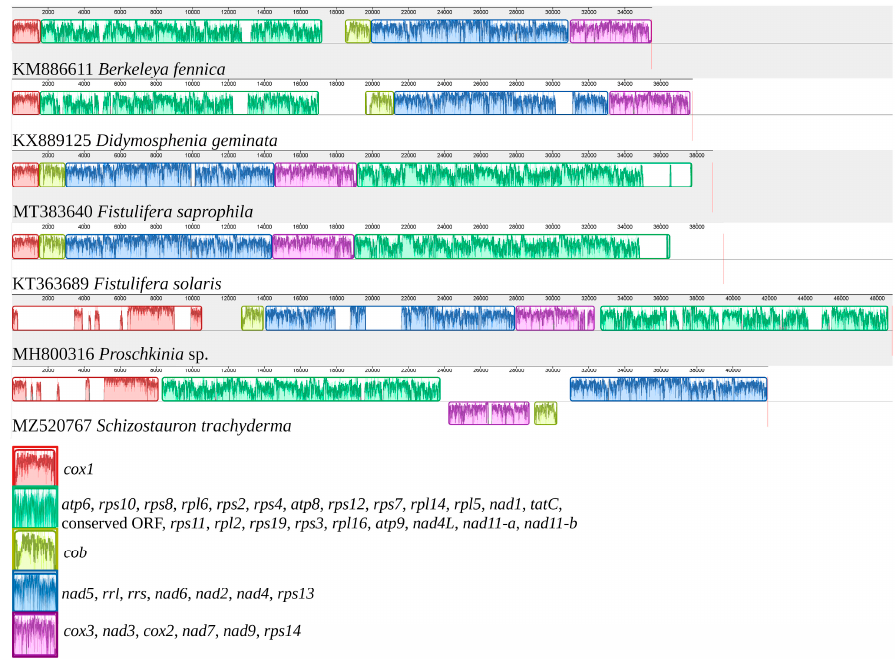
Figure 3. MAUVE alignment of the mitochondrial genomes of Berkeleya fennica (KM886611), Didymosphenia geminata (KX889125), Fistulifera saprophila (MT383640), Fistulifera solaris (KT363689), Proschkinia sp. (MH800316), and Schizostauron trachyderma (MZ520767). The legend below shows the gene content of the blocks of synteny (conserved protein-coding genes and rRNA only).